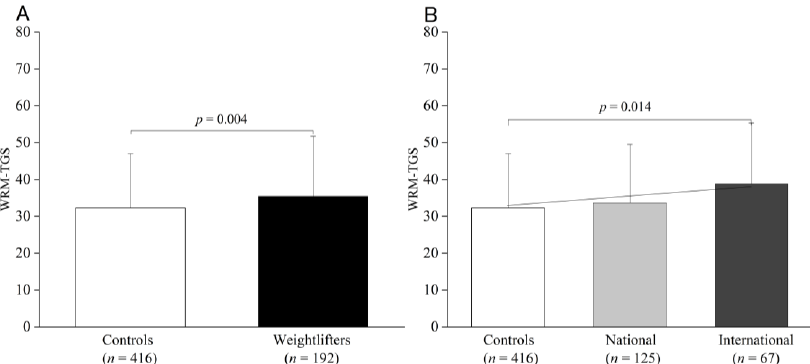
Figure 2. WRM of controls and weightlifters ( A ) and of the controls and the national and international groups ( B ). The values are presented as mean ± SD.